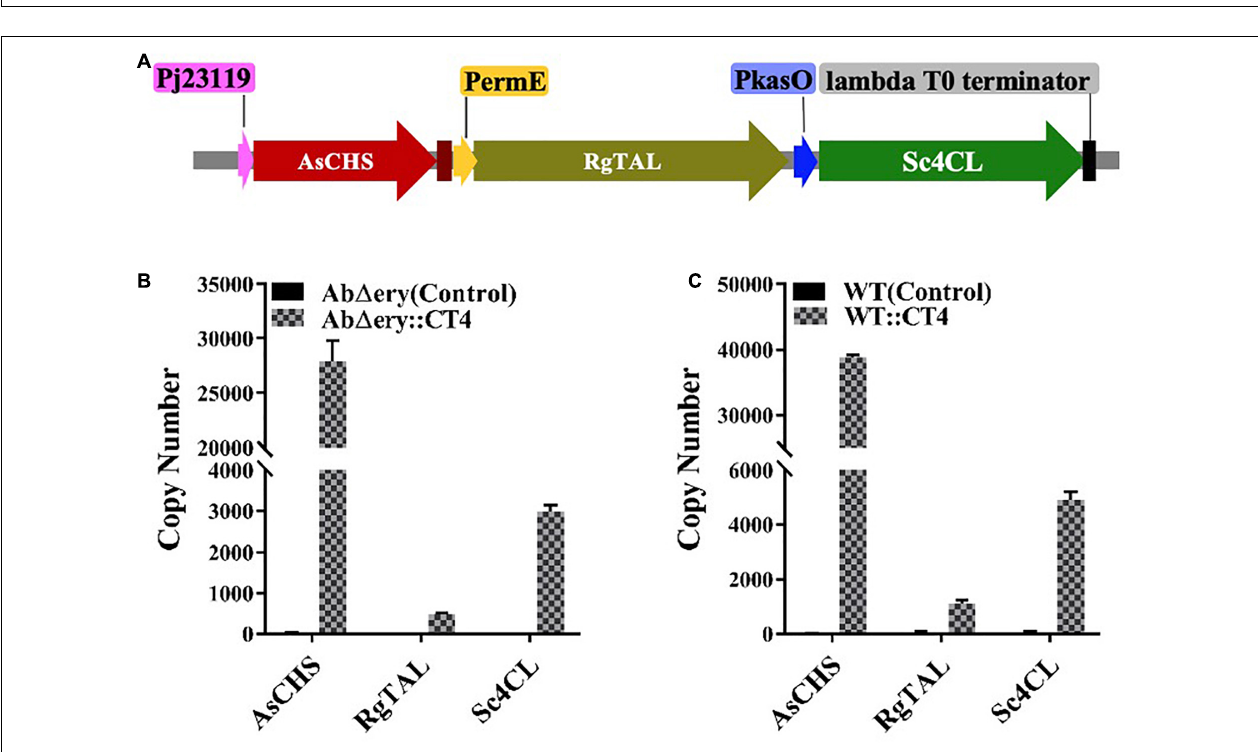
FIGURE 5 | Confirm of pSET152-Pj23119-AsCHS-PermE-RgTAL-PkasO-Sc4CL plasmids. (A) Schematic diagram of heterologous genes expression cassette (Pj23119-AsCHS-PermE-RgTAL-PkasO-Sc4CL) in pSET152. (B) qRT-PCR analysis expression of AsCHS, RgTAL, and Sc4CL in Ab (cid:49) ery :CT4 with Ab (cid:49) ery as control. (C) qRT-PCR analysis expression of AsCHS, RgTAL, and Sc4CL in WT:CT4 with WT as control. Transcript levels were obtained individually after drawing a standard curve using Ct value and copy number logarithm as the horizontal and vertical coordinates with a serial copy number gradient plasmid as a control. Error bars indicate the standard deviations from three independent replicates.